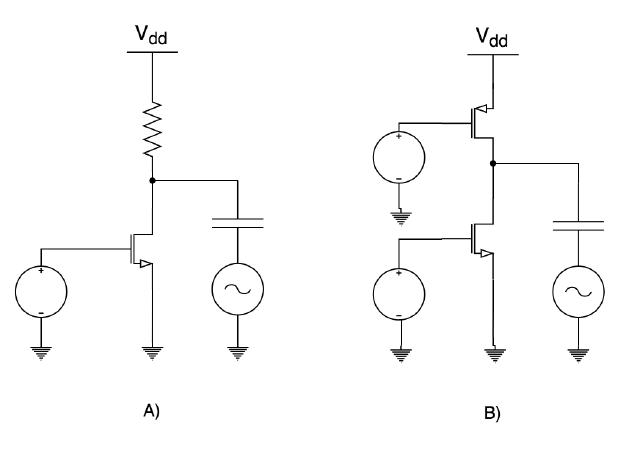
Figure 9. Schematics of the common source stage, with passive ( A ) and active ( B ) load respectively.